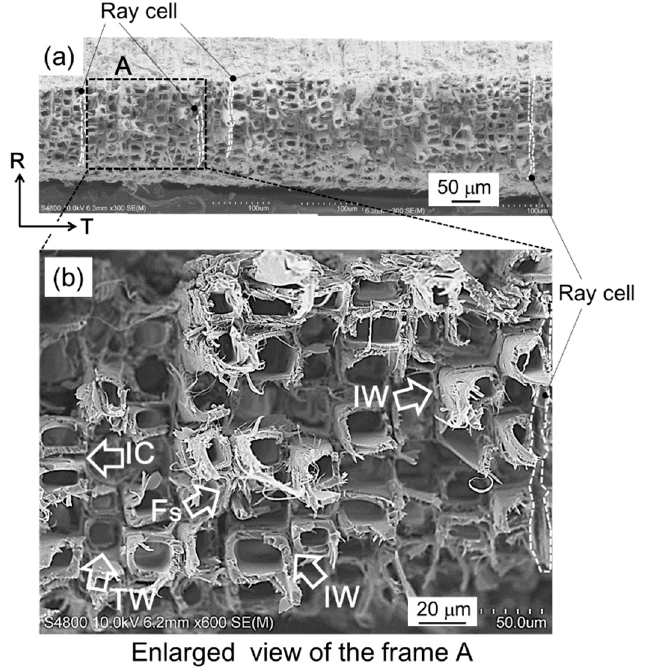
Figure 12. SEM image of the T-R fracture surface indicating the behavior of the tensile fracture. The enlarged view ( b ) is section A surrounded by the dashed lines in ( a ).